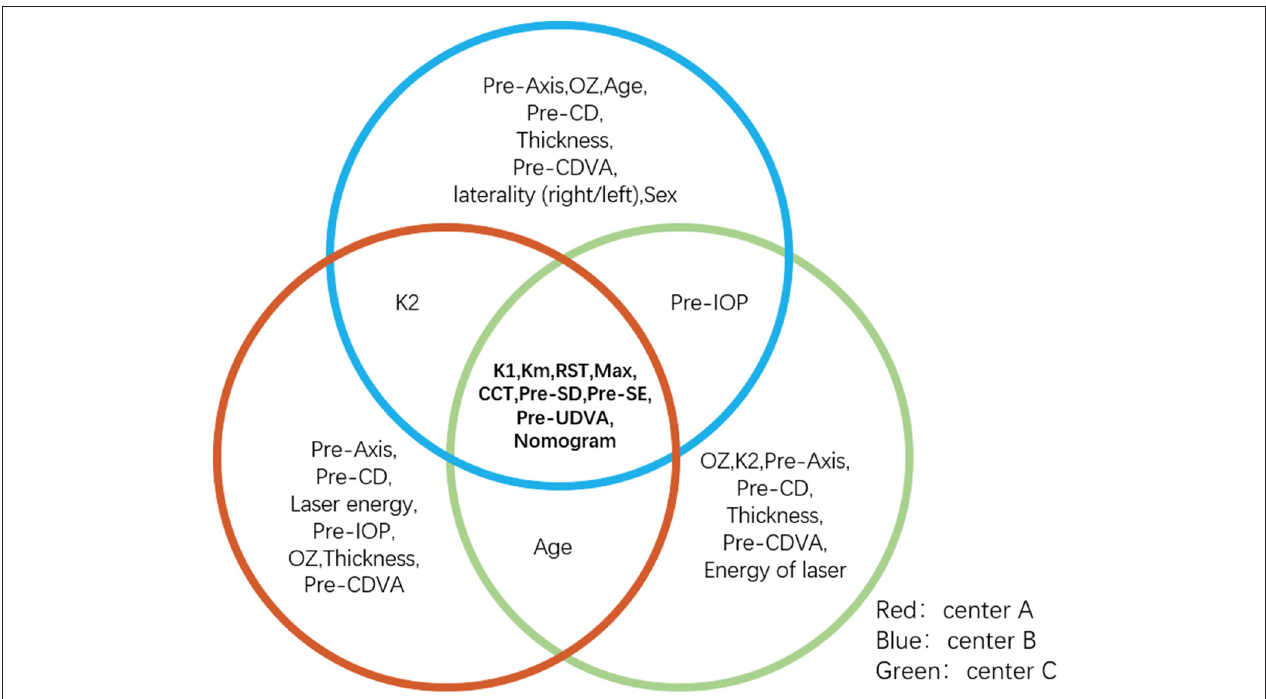
FIGURE 1 | The overlap part of the circle is the feature with three ophthalmic centers information gain values > 0.05, which are considered important factors affecting postoperative SE. K1, Km, RST, Max, CCT, Pre-SD, Pre-SE, Pre-UDVA, and nomogram make a large contribution to postoperative refraction after SMILE. CCT, central corneal thickness; K1, flattest anterior corneal curvature; Km, mean anterior corneal curvature; Max, maximum lenticule thickness; Pre-UDVA, preoperative uncorrected distance visual acuity; Pre-SD, preoperative spherical diopter; Pre-SE, preoperative spherical equivalent; SMILE, small-incision lenticule extraction; RST, residual stromal